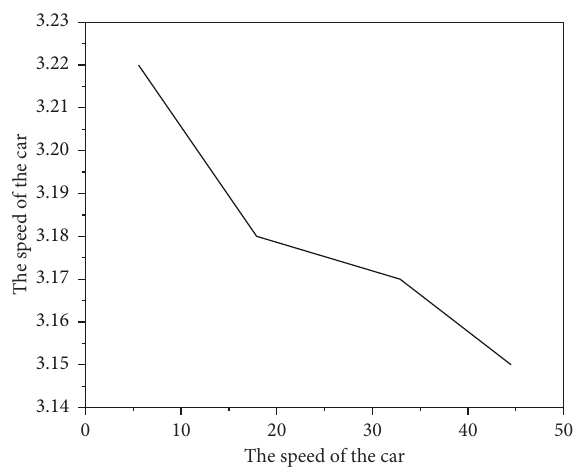
Figure 4: The main frequencies of the sports car test at no speed.